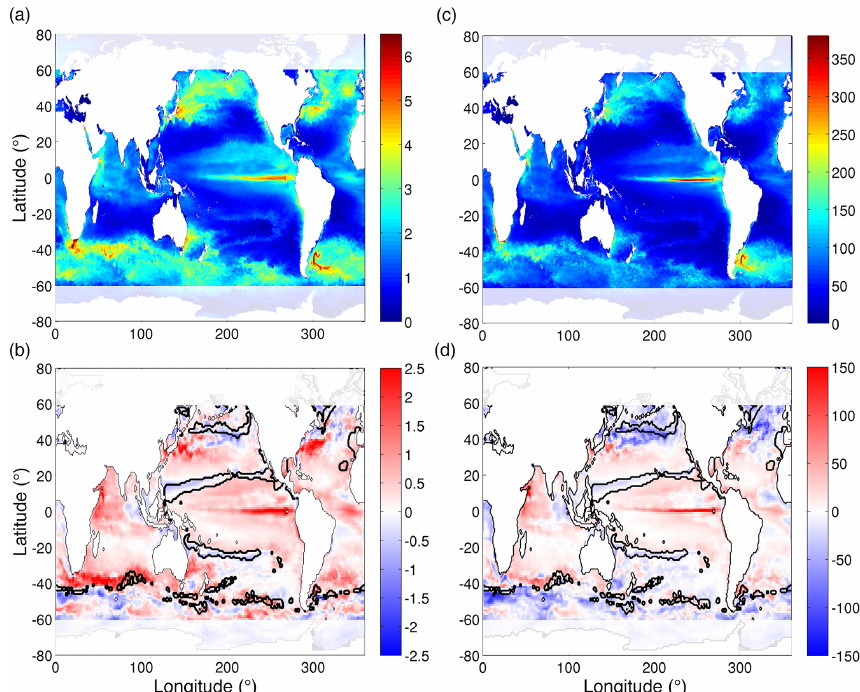
Figure 2. (a) Annual average total phytoplankton biomass in gCm − 2 and (c) annual primary production in gCm − 2 yr − 1 in the HR model solution for 1999. (b) The difference in phytoplankton biomass and (d) the difference in annual primary production. Positive values indicate higher values in the HR simulation, and negative values indicate higher values in the CR simulation. The solid black contour lines in (b, d) indicate the region where the limiting nutrient differs between the two model